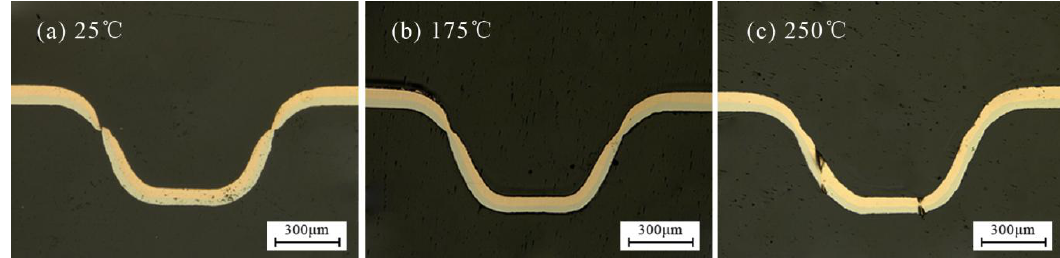
Figure 14. The change process of thickness thinning ratio with temperature at 1800 mJ: ( a ) 25 °C, ( b ) 175 °C and ( c ) 250 °C.